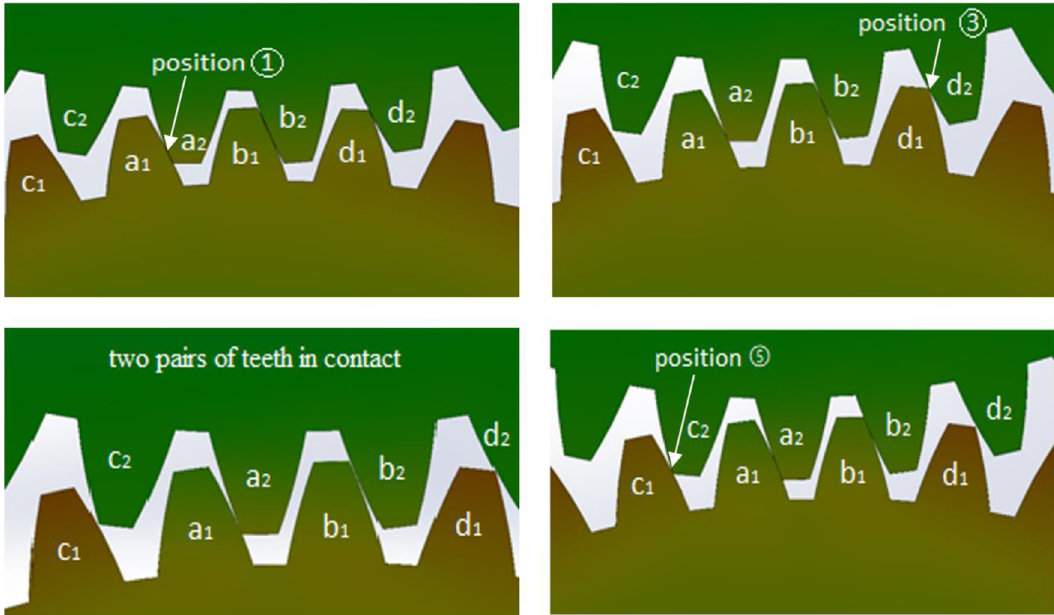
Fig. 12. Results obtained by the FEM for the pair of 40/40 plastic gear